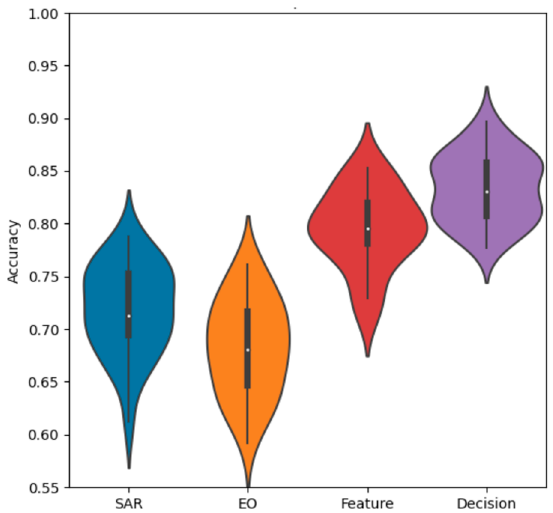
Figure 6. Accuracy distributions of fusion methods with a simple net.